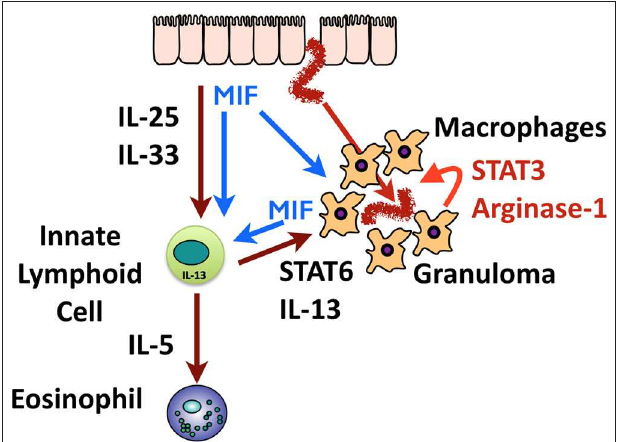
FIGURE 9 | Graphical summary of the role of MIF in immunity to H polygyrus. Invading helminths elicit release of epithelial alarmins (IL-25 and IL-33) and most likely, MIF. These innate activators act on macrophages and ILCs; macrophages activated by MIF, and by IL-13 from ILCs, swarm around the tissue helminth to form the granuloma. High levels of MIF are also produced within the granuloma which may auto-stimulate macrophages, drive Arginase-1 expression, and act on distant ILCs. ILC2s also produce IL-5 which stimulates eosinophilia in the